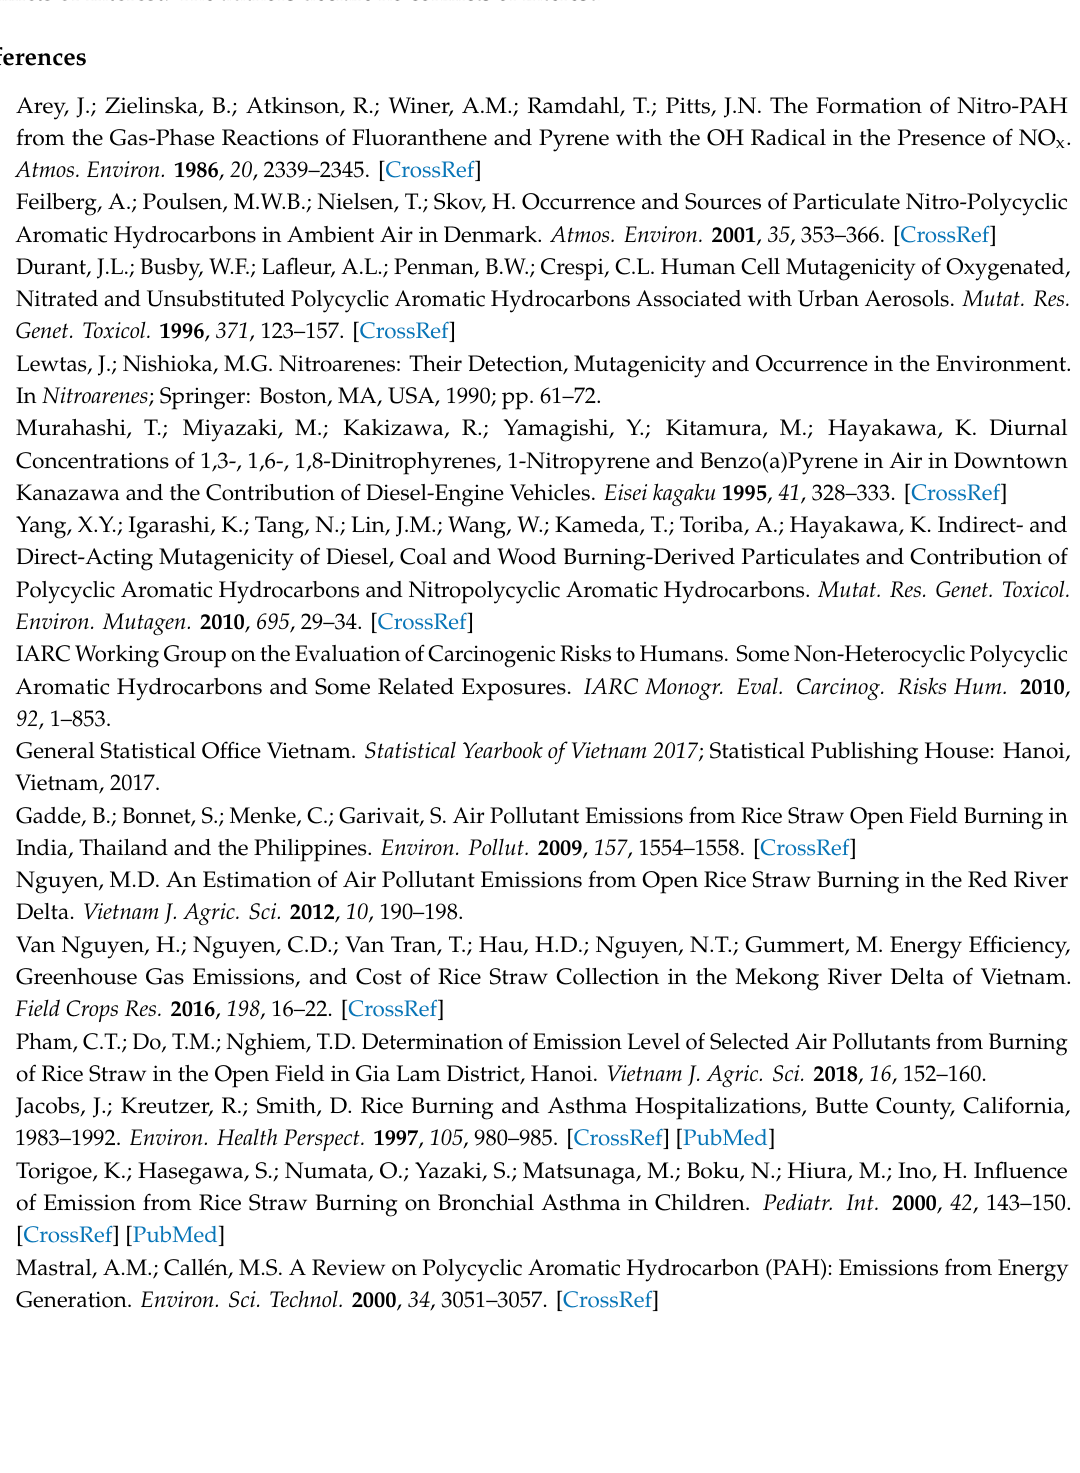
Table S1: Sampling information for PM 2.5 , Table S2: Sampling information for